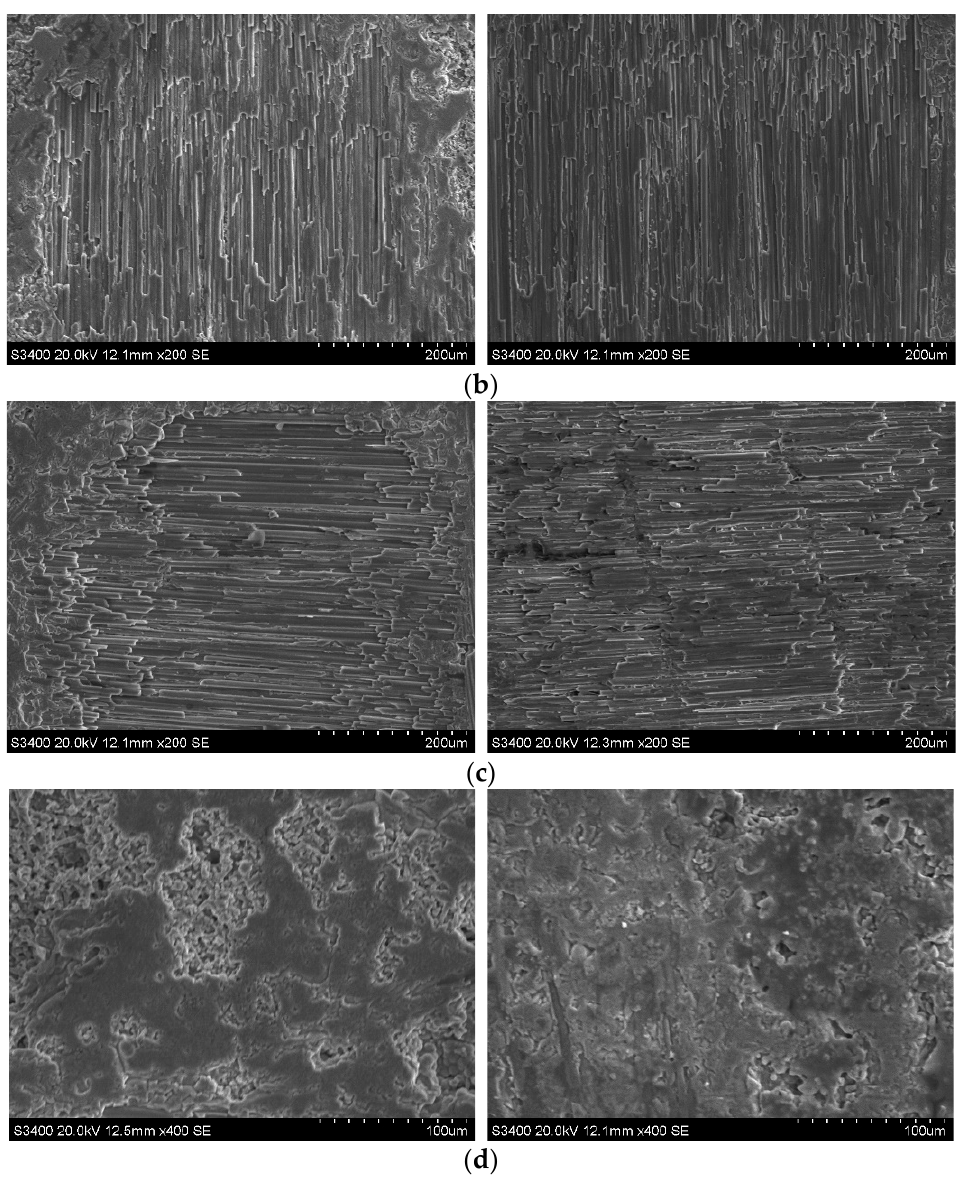
Figure 12. Micromorphology of the C/SiC composite after end face grinding: (left) CG; (right) UAG(v s = 12.6 m/s, a p = 0.1 mm, v w = 0.05 m/min). ( a ) Pores. ( b ) 0° fibers. ( c ) 90° fibers. ( d ) SiC region.